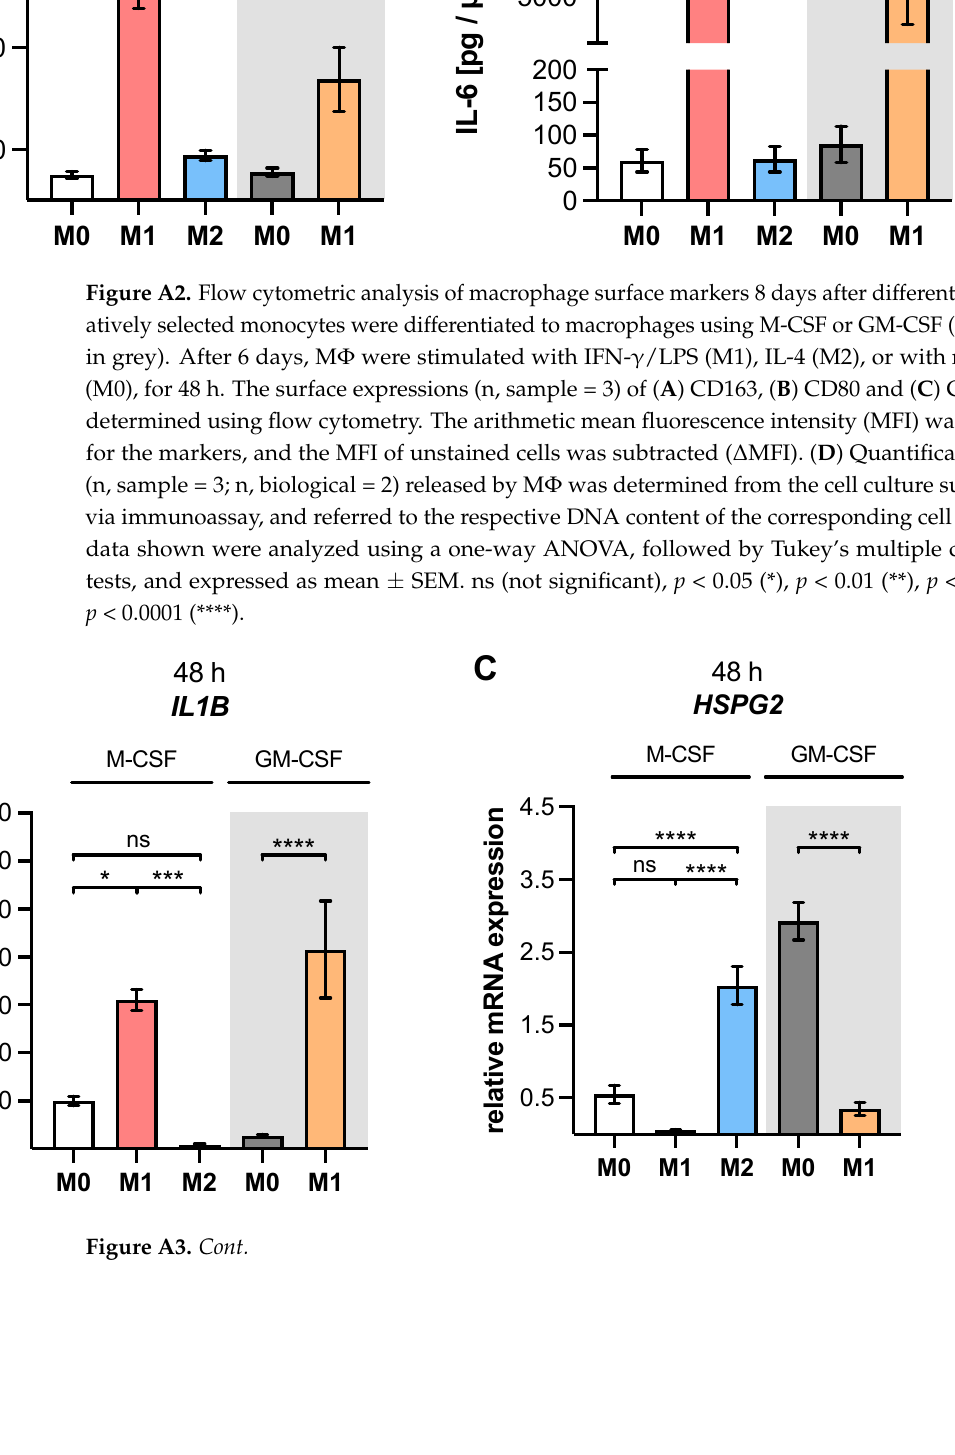
Figure A3. Gene expressions of polarized human monocyte-derived macrophages. Negatively selected monocytes (n, sample = 3; n, biological = 2; n, technical = 3) were differentiated to macrophages using M-CSF or GM-CSF (highlighted in grey). After 6 days, M Φ were stimulated with IFN- γ /LPS (M1), IL-4 (M2), or with no additive (M0). Cells were harvested after a polarization time of 48 h. The relative gene expressions of ( A ) IL1B , ( B ) IL8, ( C ) HSPG2 and ( D ) SDC2 were determined using qRT-PCR. The data were analyzed using a one-way ANOVA, followed by Tukey’s multiple comparison tests, and expressed as mean ± SEM. ns (not significant), p < 0.01 (**), p < 0.001 (***), p < 0.0001 (****). References 1. Wynn, T. Cellular and molecular mechanisms of fibrosis. J. Pathol. 2008 , 214 , 199–210. https://doi.org/10.1002/path.2277. 2. Hinz, B.; Lagares, D. Evasion of apoptosis by myofibroblasts: A hallmark of fibrotic diseases. Nat. Rev. Rheumatol. 2020 , 16 , 11– 31. https://doi.org/10.1038/s41584-019-0324-5. 3. Pakshir, P.; Hinz, B. The big five in fibrosis: Macrophages, myofibroblasts, matrix, mechanics, and miscommunication. Matrix Biol. 2018 , 68–69 , 81–93. https://doi.org/10.1016/j.matbio.2018.01.019. 4. Mack, M.; Yanagita, M. Origin of myofibroblasts and cellular events triggering fibrosis. Kidney Int. 2015 , 87 , 297–307. https://doi.org/10.1038/ki.2014.287. 5. Vierhout, M.; Ayoub, A.; Naiel, S.; Yazdanshenas, P.; Revill, S.D.; Reihani, A.; Dvorkin-Gheva, A.; Shi, W.; Ask, K. Monocyte and macrophage derived myofibroblasts: Is it fate? A review of the current evidence. Wound Repair Regen. 2021 , 29 , 548–562. https://doi.org/10.1111/wrr.12946. 6. Orekhov, A.N.; Orekhova, V.A.; Nikiforov, N.G.; Myasoedova, V.A.; Grechko, A.V.; Romanenko, E.B.; Zhang, D.; Chistiakov, D.A. Monocyte differentiation and macrophage polarization. Vessel Plus 2019 , 2019 , 10. https://doi.org/10.20517/2574- 1209.2019.04. 7. Marimuthu, R.; Francis, H.; Dervish, S.; Li, S.C.H.; Medbury, H.; Williams, H. Characterization of human monocyte subsets by whole blood flow cytometry analysis. J. Vis. Exp. 2018 , 140 , e57941. https://doi.org/10.3791/57941. 8. Okabe, Y.;